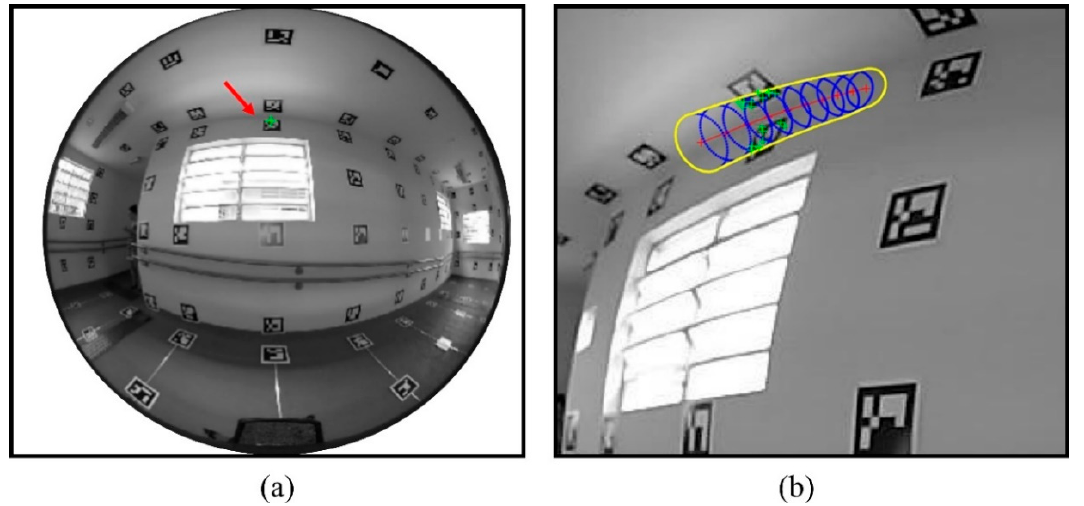
Figure 3. ( a ) Interest point in the left-image (p l ) and ( b ) search window in the right-image, in which the epipolar curve is shown in red, error ellipses in blue, the search window in yellow, and the selected scale-invariant feature transform (SIFT) keypoints in green.